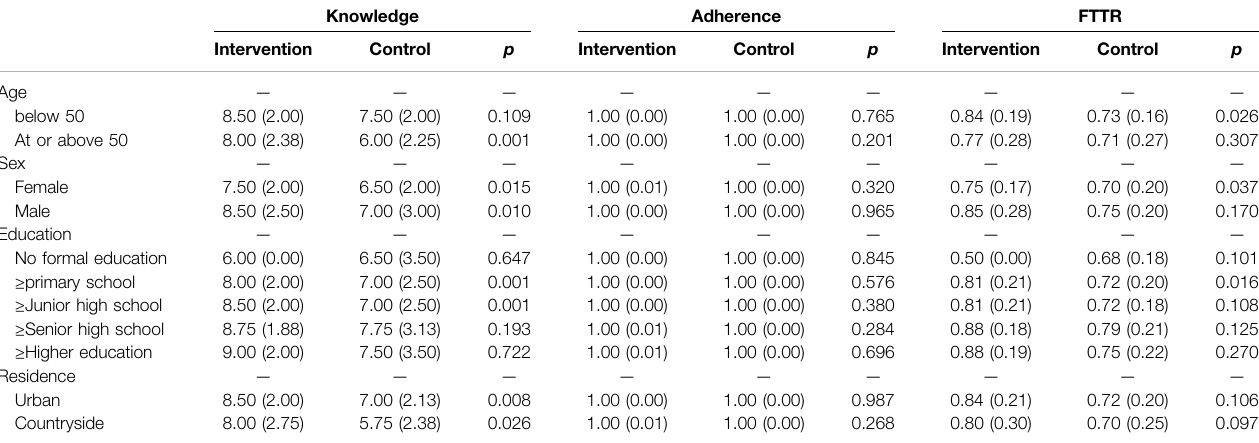
TABLE 6 | Subgroup analyses of the differences between two groups. Knowledge Adherence FTTR Intervention Control p Intervention Control p Intervention Control